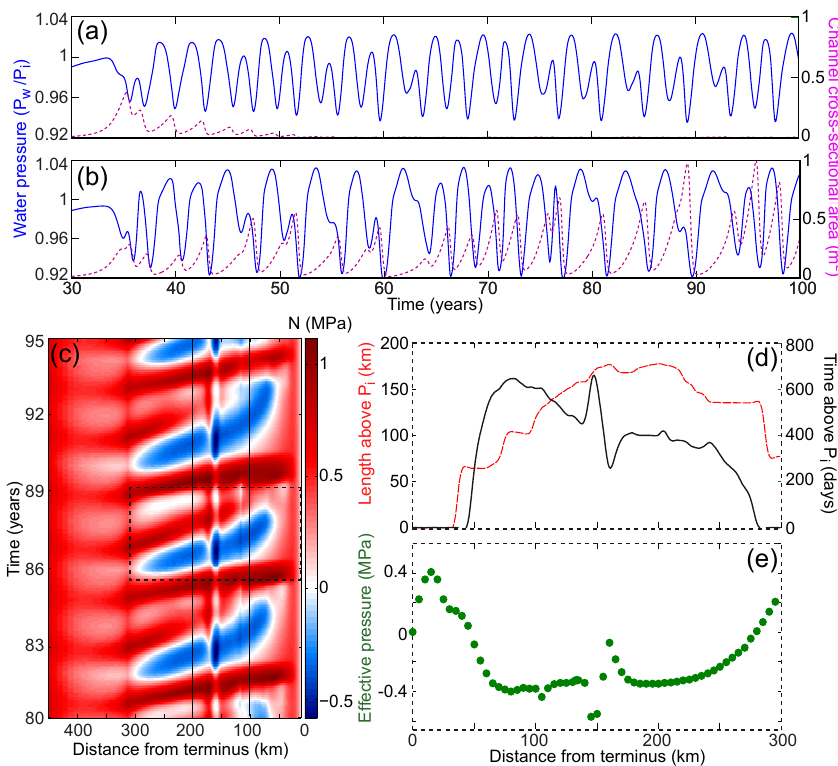
Figure 4. Model outputs from the system with the overdeepening. (a, b) Average water pressure (blue) and channel cross-sectional area (purple dashed) across the ice stream at a distance of 200 and 100km from the front, respectively, corresponding to the solid black lines in (c) . (c) Time–distance plot of center line effective pressure demonstrating several pressure waves. The dashed box shows the feature analyzed in (d) and (e) . (d) Longitudinal length affected by negative effective pressures at the time of pressure wave passing (red dashed curve) and the time of an area below negative effective pressure (black curve) along the ice stream. (e) Minimum effective pressure (green) along the ice